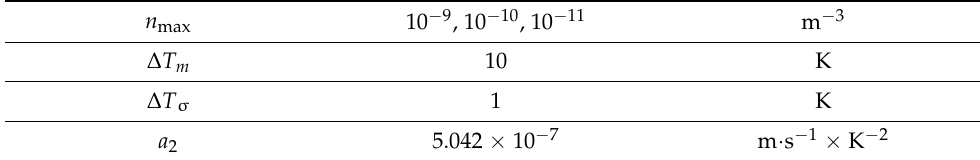
Table 2. Parameters of nucleation and growth kinetics